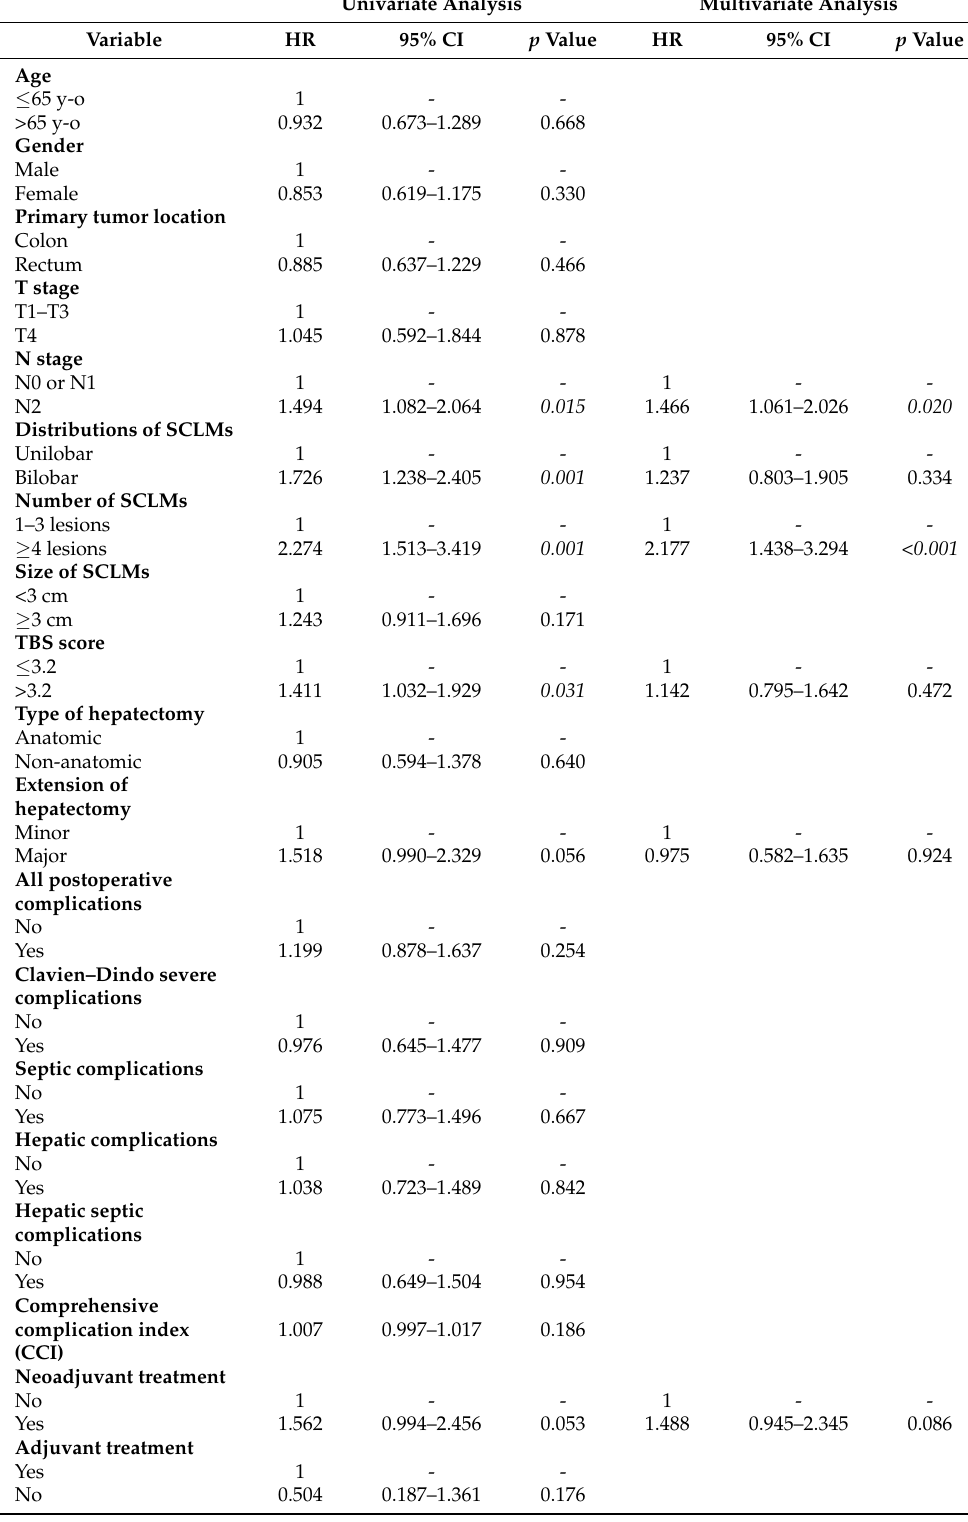
Table 3. Univariate and multivariate analysis of prognostic factors for DFS. Univariate Analysis Multivariate